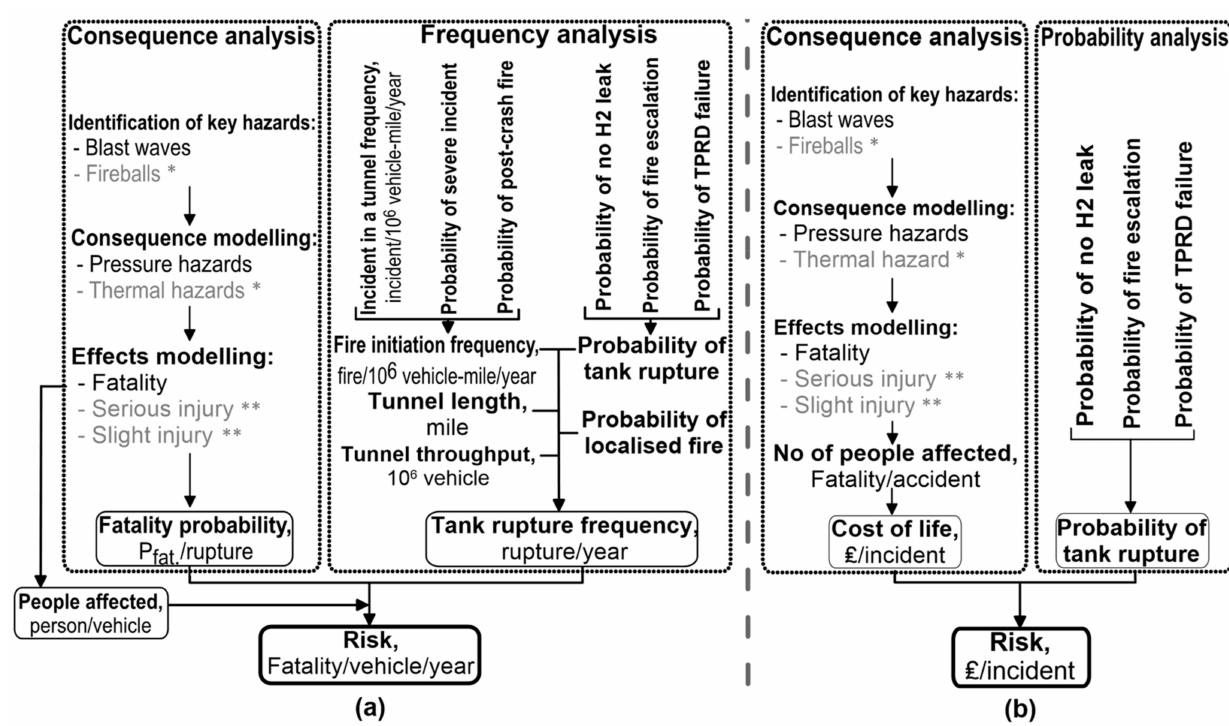
Figure 1. The QRA methodology flowchart for HFCV in a tunnel: ( a ) risk in terms of fatality per vehicle per year; ( b ) risk in terms of monetary losses per incident. *—fireball and thermal hazards are excluded from consideration in this study due to the current unavailability of the tool for assessment of a fireball propagation inside tunnels; **—serious and slight injuries are excluded from consideration in this study; only fatalities are